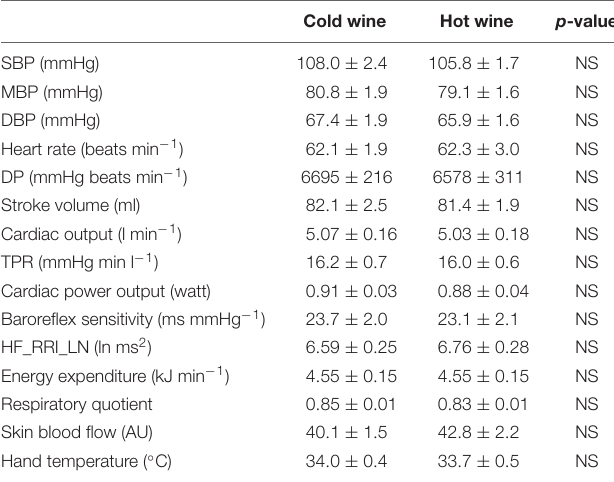
TABLE 1 | Baseline cardiovascular and metabolic data recorded before wine ingestion in 14 ) (cid:104)